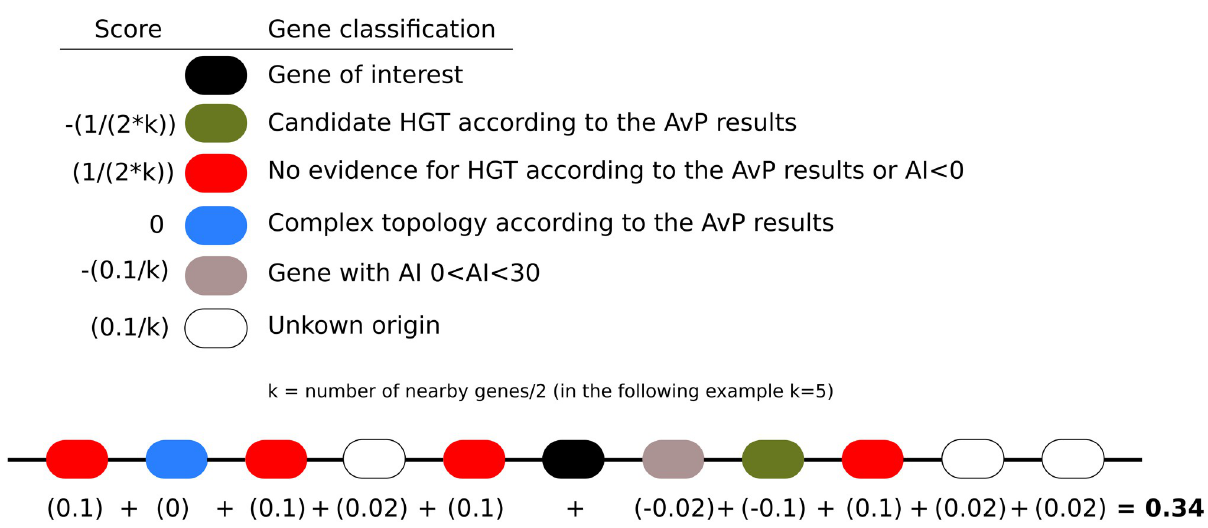
Fig 3. HGT local score calculation. Each neighbouring gene contributes to the score based on its classification getting a value described in the top left panel. In the example, the score is equal to 0.34, most likely indicating an HGT insertion. Overall, a score above 0 indicates an HGT insertion, while a score below 0 indicates a possible contamination or HGT rich